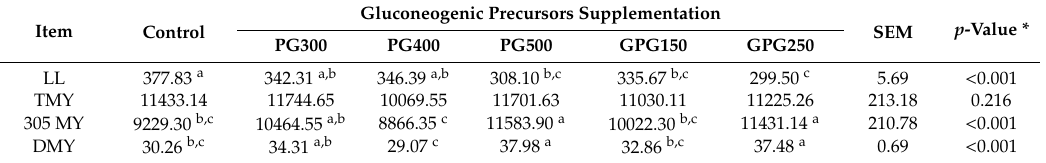
Table 3. E ff ect of di ff erent drenching regimens by gluconeogenic precursors on productive performance.